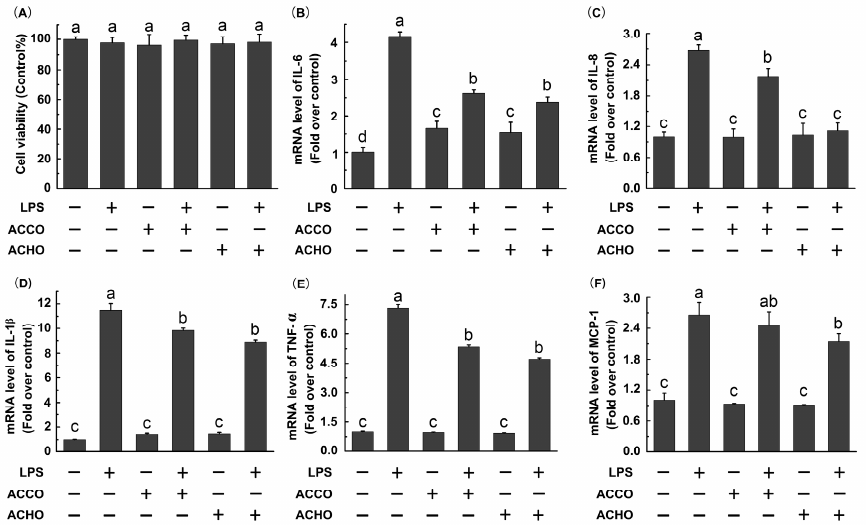
Figure 2. Effects of ACCO and ACHO on viability and inflammatory reaction in lipopolysaccharide (LPS)-stimulated macrophage cells. ( A ) RAW264.7 cells were treated with LPS (200 ng/mL), ACCO (100 μ g/mL) or ACHO (100 μ g/mL) for 24 h. After that, the cell viability was tested by a MTT assay; ( B – F ) RAW264.7 cells were pre-treated with ACCO (100 μ g/mL) or ACHO (100 μ g/mL) for 12 h and then exposed to LPS (200 ng/mL) for 6 h. Next, the mRNA levels of IL-6 ( B ), IL-8 ( C ), IL-1 β ( D ), TNF α ( E ) and MCP-1 ( F ) were determined by RT-PCR analysis. Data are the mean ± SD ( n = 3). Data with different superscript letters are significantly different ( p < 0.05).